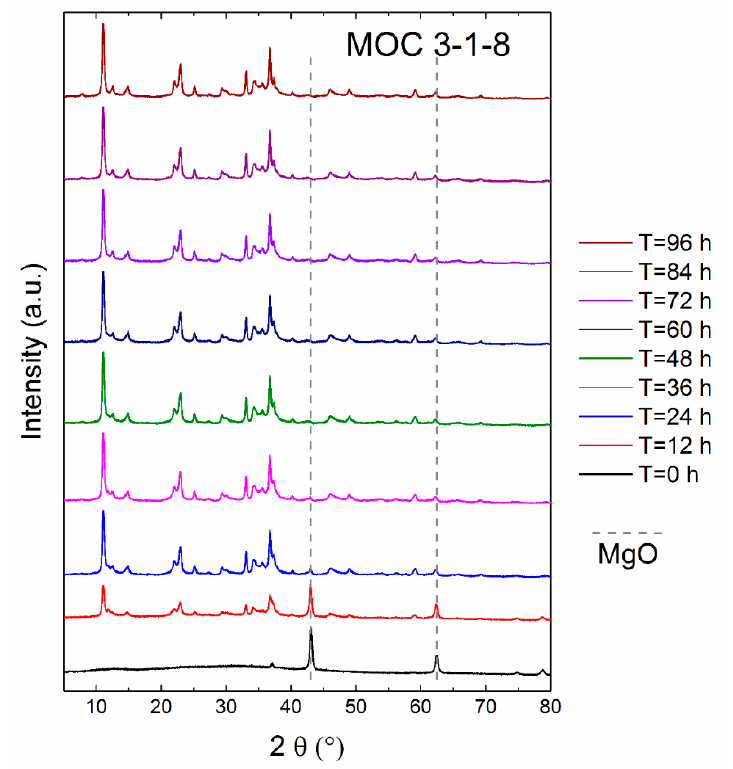
Figure 2. X-ray di ff raction patterns of magnesium oxychloride cement (MOC) 3-1-8 suspensions Figure 2. X-ray diffraction patterns of magnesium oxychloride cement (MOC) 3-1-8 suspensions measured for 96 measured for 96 h.